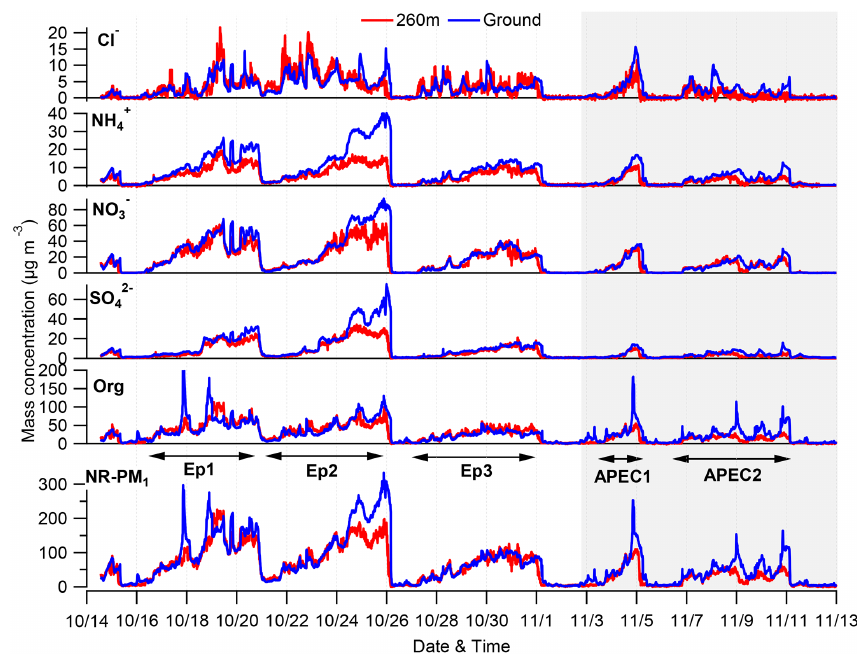
Figure 11. Comparisons of time series of total NR-PM 1 mass and NR-PM 1 species between 260m and ground